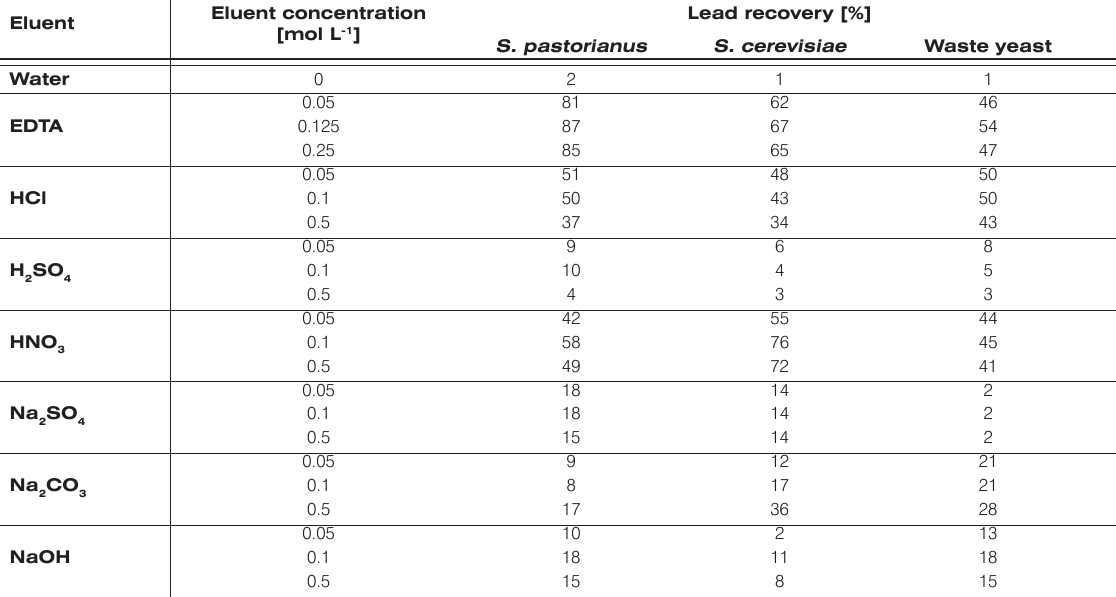
Table 4. The lead desorption efficiency of 10 mL of various eluents (liquid to solid ratio of 0.02 L g -1 ). Eluent concentration Eluent [mol L -1